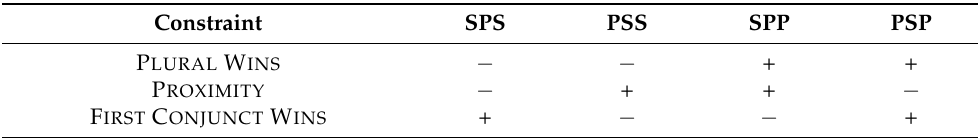
Table 14. Predictions made by Peterson’s (1986) constraints for agreement in number conflict cases (S = singular, P =